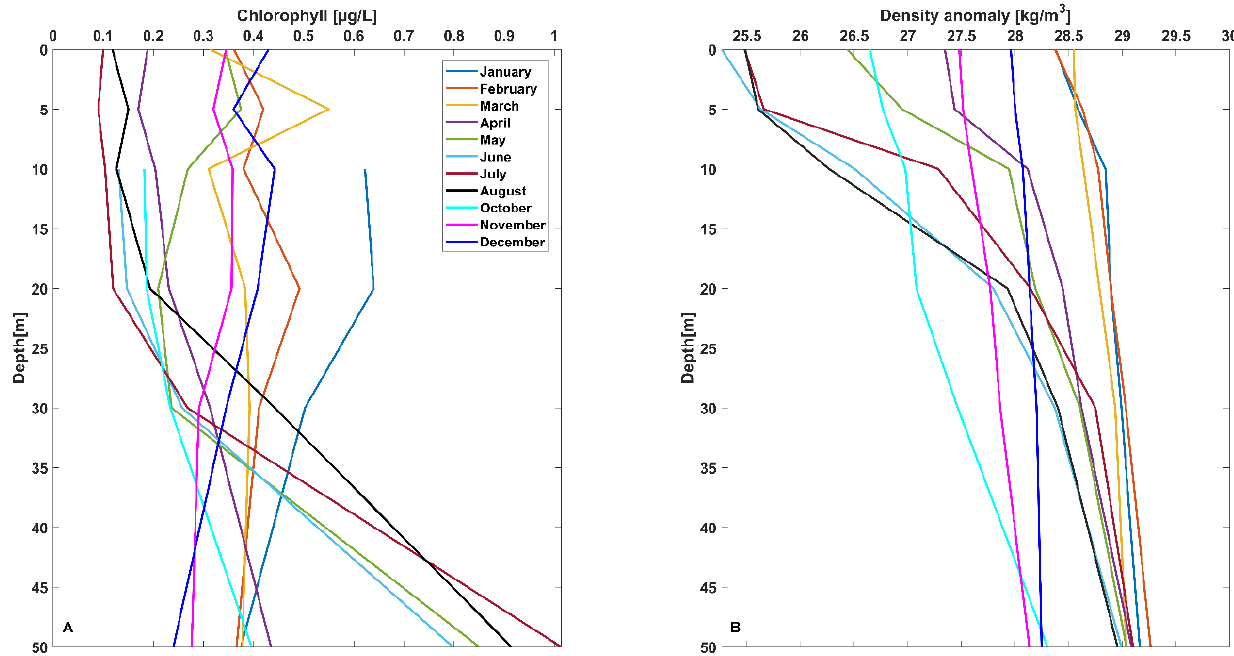
Figure 6. Geometric mean vertical chlorophyll ( A ) and density anomaly ( B ) concentrations observed during the 2012–2019 period at the measuring station, FP-O14.